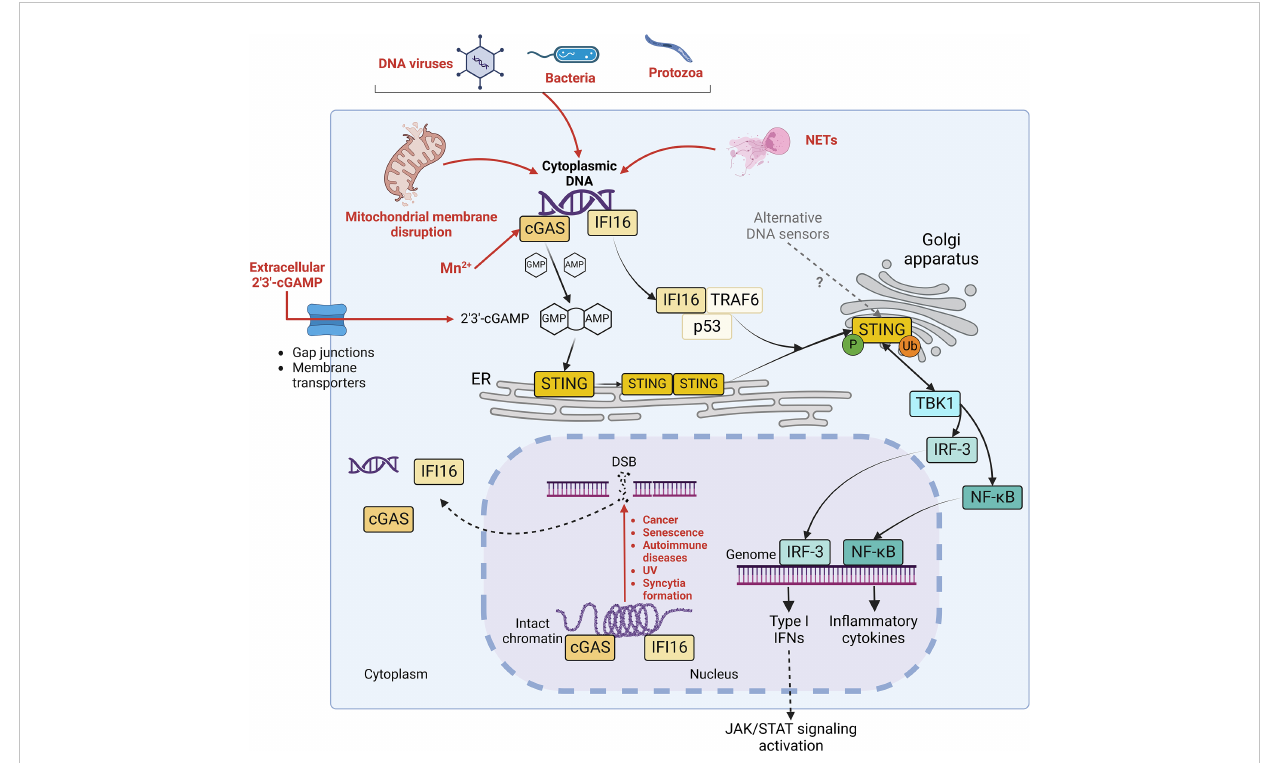
FIGURE 1 STING signalling pathways. Diverse stimuli (in red), including infections by DNA virus, bacteria or protozoa, mitochondrial membrane disruption, possible Mn 2+ release, extracellular cGAMP import and neutrophil extracellular traps (NETs) generation trigger the release of intracellular DNA in the cytoplasm. Moreover, double strand breaks (DSB) in genomic DNA, occurring during cancer, senescence, autoimmune disorders, UV exposure and membrane fusion, contribute to the liberation of self-DNA in cytosol and to the dissociation of cGAS and IFI16 (in yellow) from intact chromatin. Both cGAS and IFI16 detect cytoplasmic DNA (in purple). However, while cGAS activates STING by synthesizing its agonist 2 ’ 3 ’ -cGAMP, IFI16 elicits STING activation through a non-canonical mechanism in complex with p53 and TRAF6. Once activated, STING oligomerizes and translocates to Golgi apparatus, where it undergoes phosphorylation and ubiquitination. Consequently, it stimulates the nuclear translocation of IRF-3 and NF-kB transcription factors and further expression of IFN I and in fl ammatory cytokines, leading to the activation of JAK/STAT signaling pathway in autocrine and paracrine